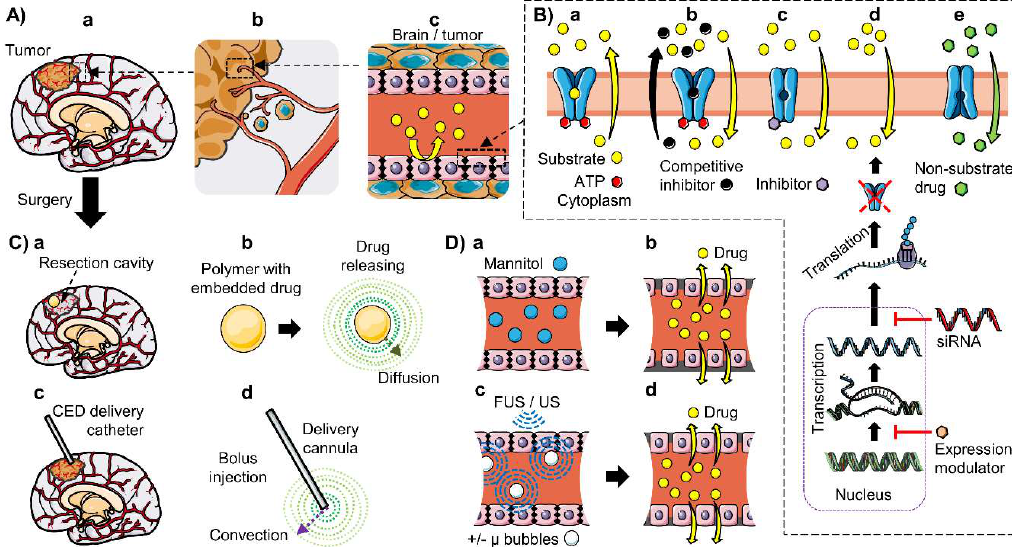
Figure 4. Schemas of some of the main drug delivery strategies to overcome the blood–brain barrier (BBB) and the blood–brain tumor barrier (BBTB) to treat glioma with chemotherapeutics. ( A ) ( a ) Brain gliomas may be extensively blood irrigated, ( b ) and infiltrative cells may spread to the vascularized parenchyma; ( c ) therefore, drug delivery is strongly restricted by the BBB and the BBTB. Diverse drug delivery strategies have been developed, for instance: ( B ) Modulation of the ABC transporters, ( a ) which are responsible for the brain to blood efflux of many xenobiotics, whose activity can be tuned by ( b ) competitive or ( c ) non-competitive inhibitors, or ( d ) their expression may be downregulated using siRNA or other expression modulators; ( e ) in addition, non-ABC substrates can be discovered among natural products or developed using rational design. ( C ) The BBB may be bypassed by the local delivery of chemotherapeutics; ( a and b ) after surgery, polymers containing an embedded drug can be implanted, ( b ) which slowly release the compound that spread by diffusion; ( c ) a catheter can be implanted to ( d ) allow the localized delivery of a chemotherapeutic compound that spread by convection. ( D ) BBB disruption can be provoked: ( a ) through osmotic disruption using a hyperosmotic product such as mannitol, ( b ) causing the shrinking of the endothelial cells and the opening of the BBB; ( c ) or through focused or unfocused ultrasounds (FUS/US) that may be aided by micro bubbles, ( d ) whose vibration breaks the tight junctions (black rhombus ♦ ) and allows the entry of the drug. Created using images from “smart Servier Medical Art”, Creative Commons License, 2019.